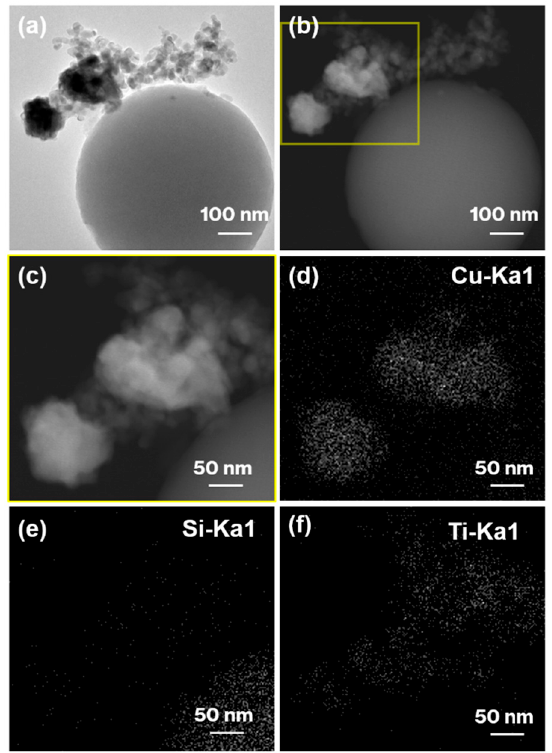
Figure 4. ( a ) TEM and ( b ) STEM images of Cu–P25–ASP. The region indicated by the yellow square in ( b ) is enlarged in ( c ). EDX mapping image for Cu, Si, and Ti in figure ( c ) are shown in figures ( d – f ), respectively.